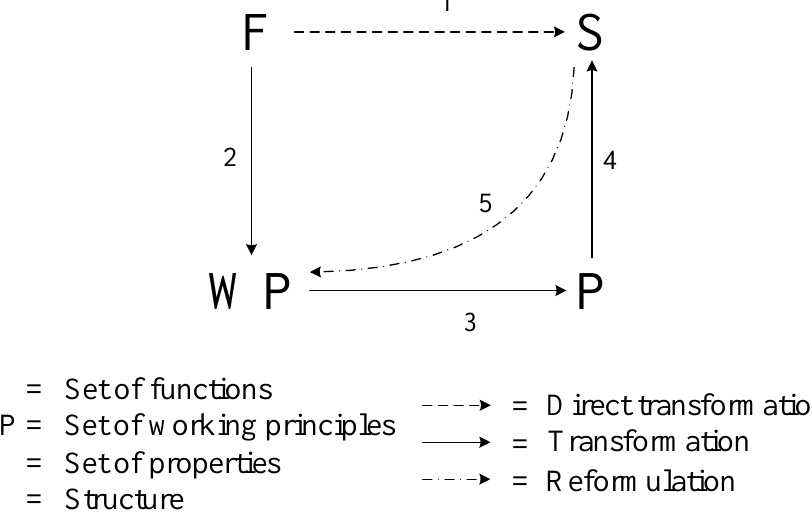
Figure 5. The extended functional design approach, based on the working principle (WP) and property (P).